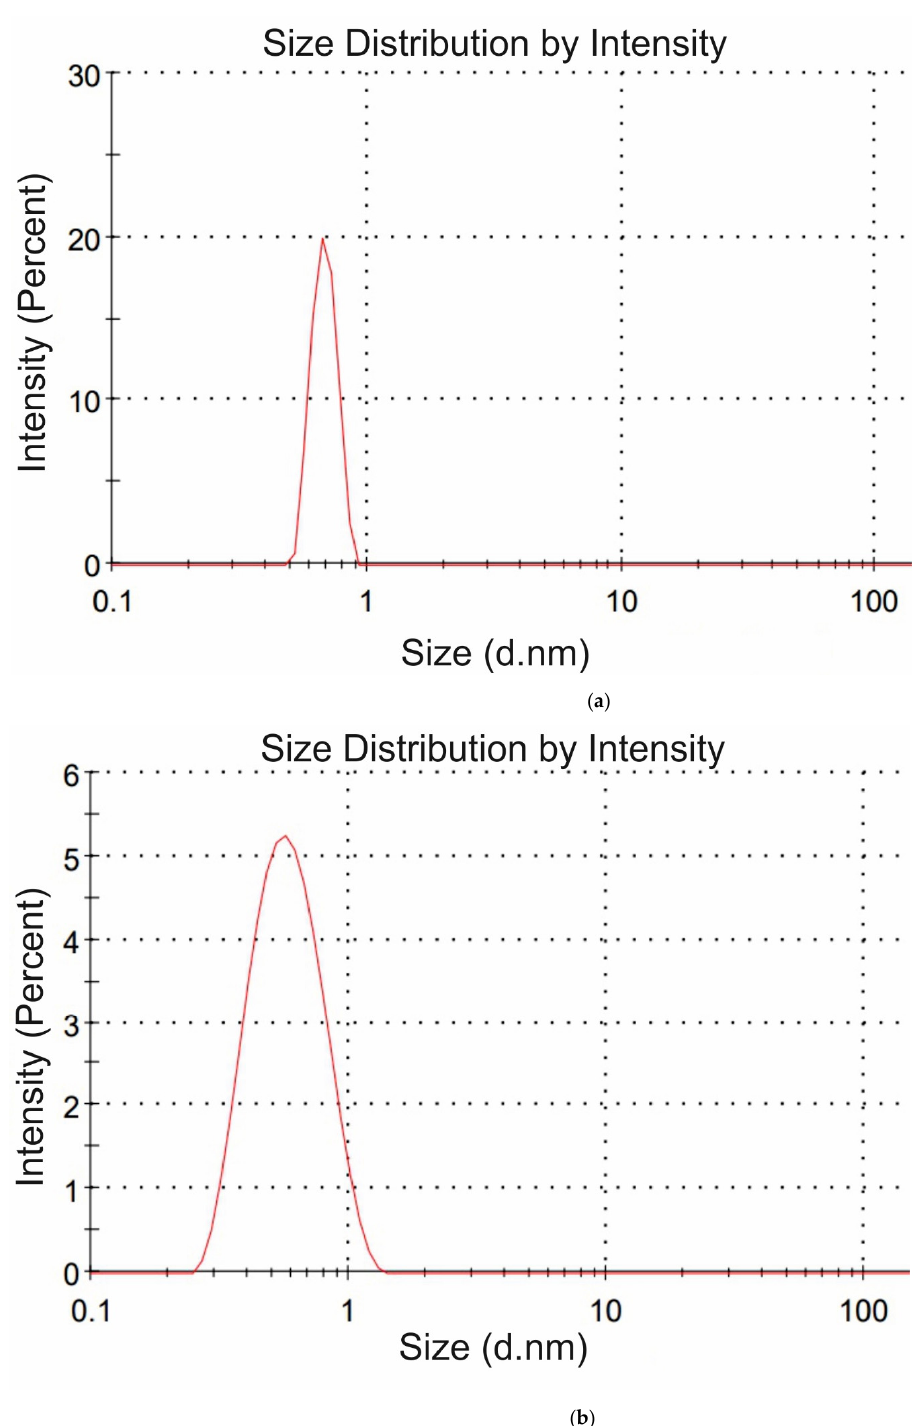
Figure 4. DLS intensity distribution over the particle diameters in suspensions of amino-acids at the scattering angle of 173°: ( a ) Lysine, ( b ) Glutamic acid. Table 1 shows the results of dynamic light scattering experiment; the literature data on the sizes and the pH values at isoelectric point (pI) of the studied amino-acids are also given. Table 1. Diameters, charges and pI values of amino-acids under study.